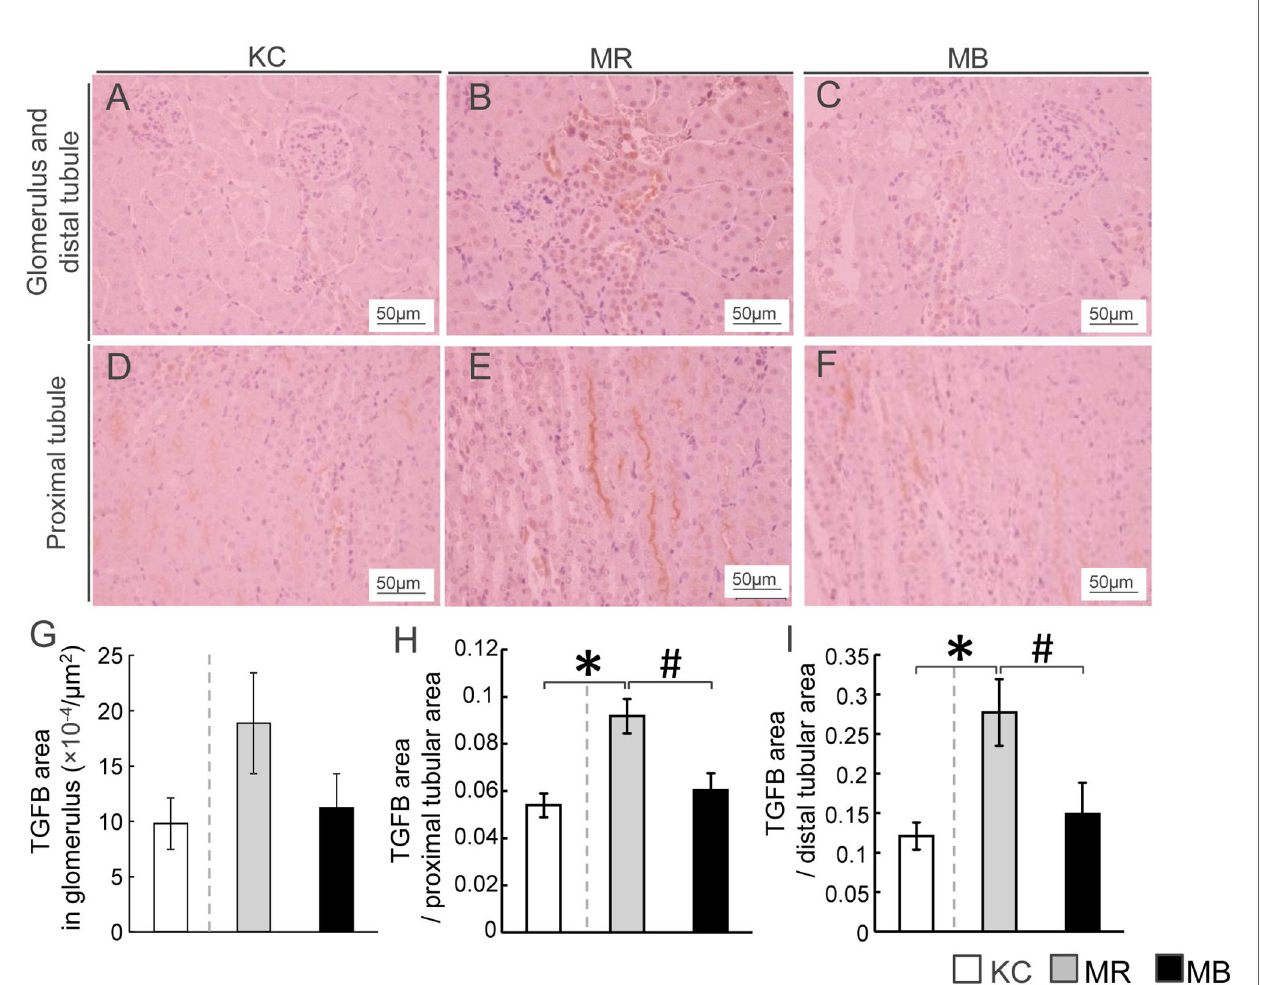
FIGURE 4 | Histopathological evaluation by immunostaining for transforming growth factor beta (TGFB) and quanti fi cation of TGFB in the mice kidney tissues after 10 weeks of experimental diet intake. (A – F) Representative histological TGFB staining of sections of the glomerulus, distal tubule (A – C) , and proximal tubule (D – F) in mice from each of the three experimental groups (TGFB-positive areas are stained orange; scale bar, 50µm). Quanti fi cation of the TGFB-positive area in the glomerulus (G) , proximal renal tubules (H) , and distal renal tubules (I) . MB, minimum essential medium (MEM) mice on a barley diet; MR, MEM mice on a rice diet; KC, potassium simplex optimized medium control mice on a rice diet. Data are expressed as the mean ± SEM for 8 – 12 animals. Data were analyzed using Student ’ s t -test. * P < 0.05 compared with the KC group; # P < 0.05 compared with the